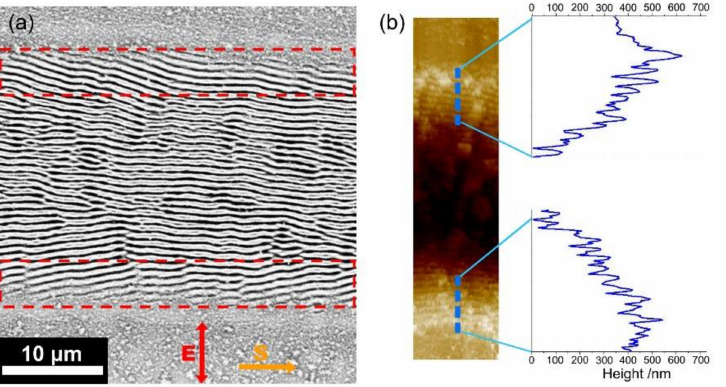
Figure 7. ( a ) SEM image of the ripple structure formation on the surface of Cr bulk material irradiated by single-beam femtosecond laser pulses at the energy fluence of F = 40.6 mJ/cm 2 ; ( b ) AFM image with the cross-section profiles for the ripple structures on two edge regions of the laser-scanned